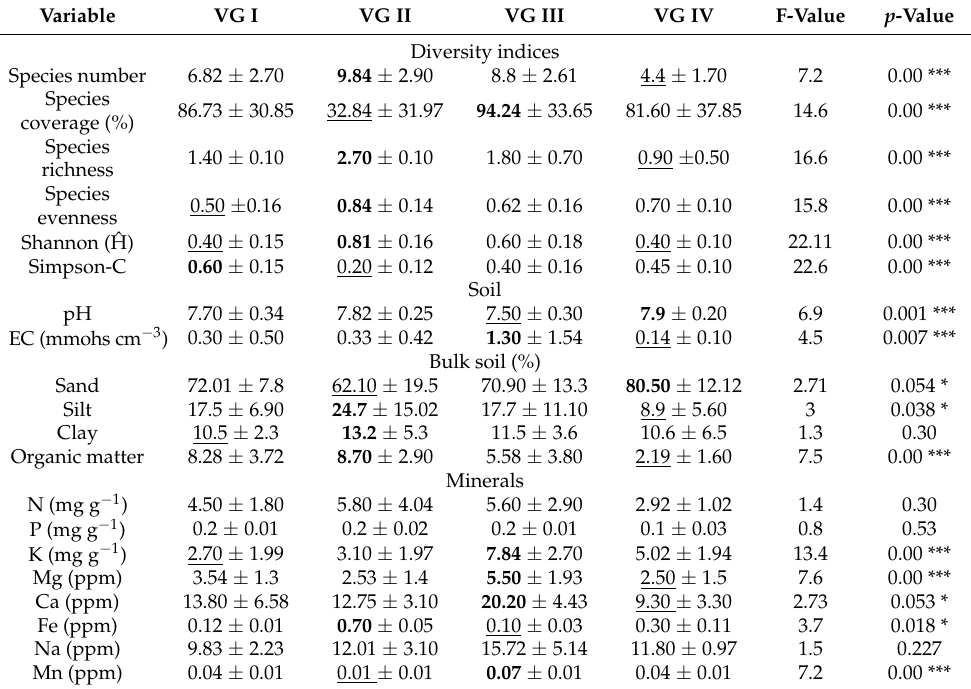
Table 4. Mean ± standard deviation values of the diversity indices and soil variables for the identified vegetation groups in the study area. VG I: Opuntia ficus-indica - Juniperus phoenicea , VG II: Reichardia tingitana - Heliotropium aegyptiacum , VG III: Prosopis juliflora - Acacia seyal - Abutilon pannosum , and VG IV: Suaeda monoica